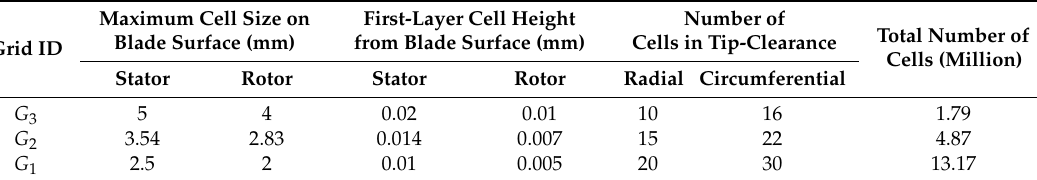
Figure 5. The surface grids for rotor and stator blades. Table 1. Key parameters of the computational